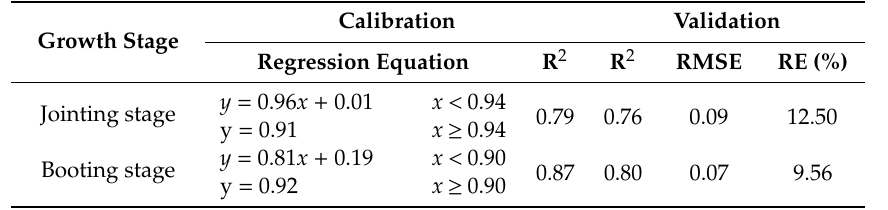
Table 4. Calibration and validation results for the relationship between relative yield (RY) and NNI at the jointing and booting stages.